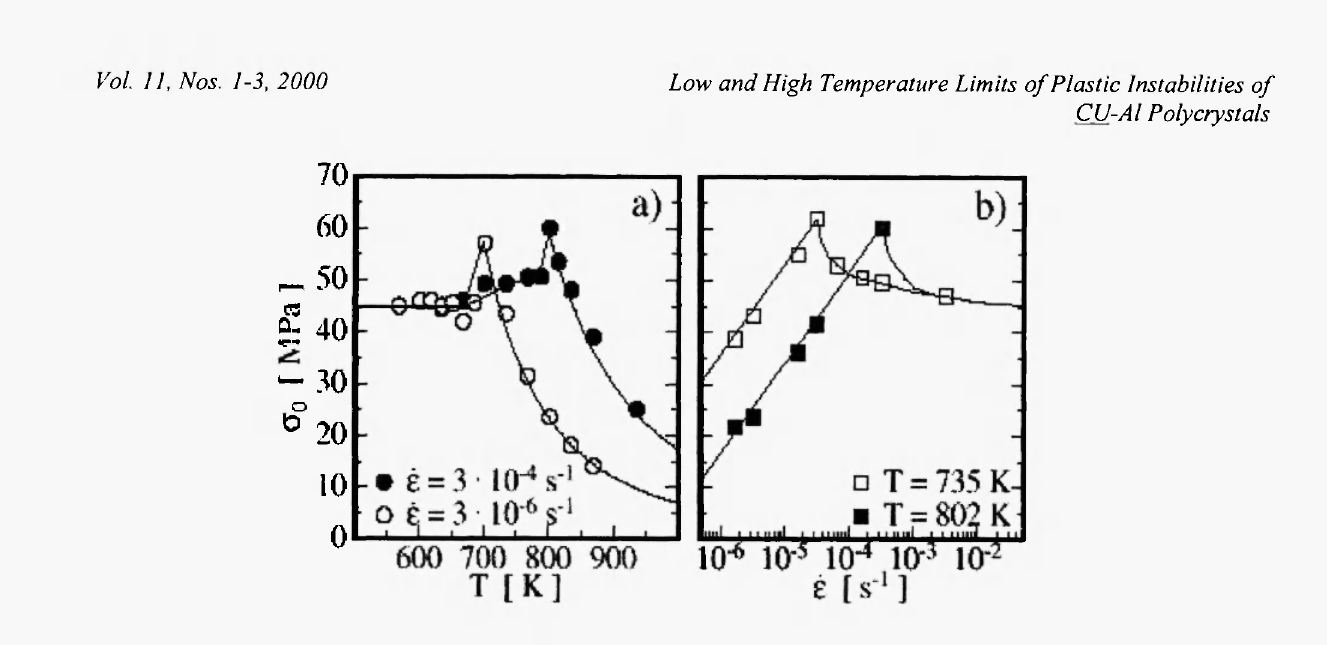
Figure 4: Critical flow stress σο of Cu 10at.% Al as dependent on Τ (a) and έ (b) in the range of the transition from discontinuous to viscous glide.